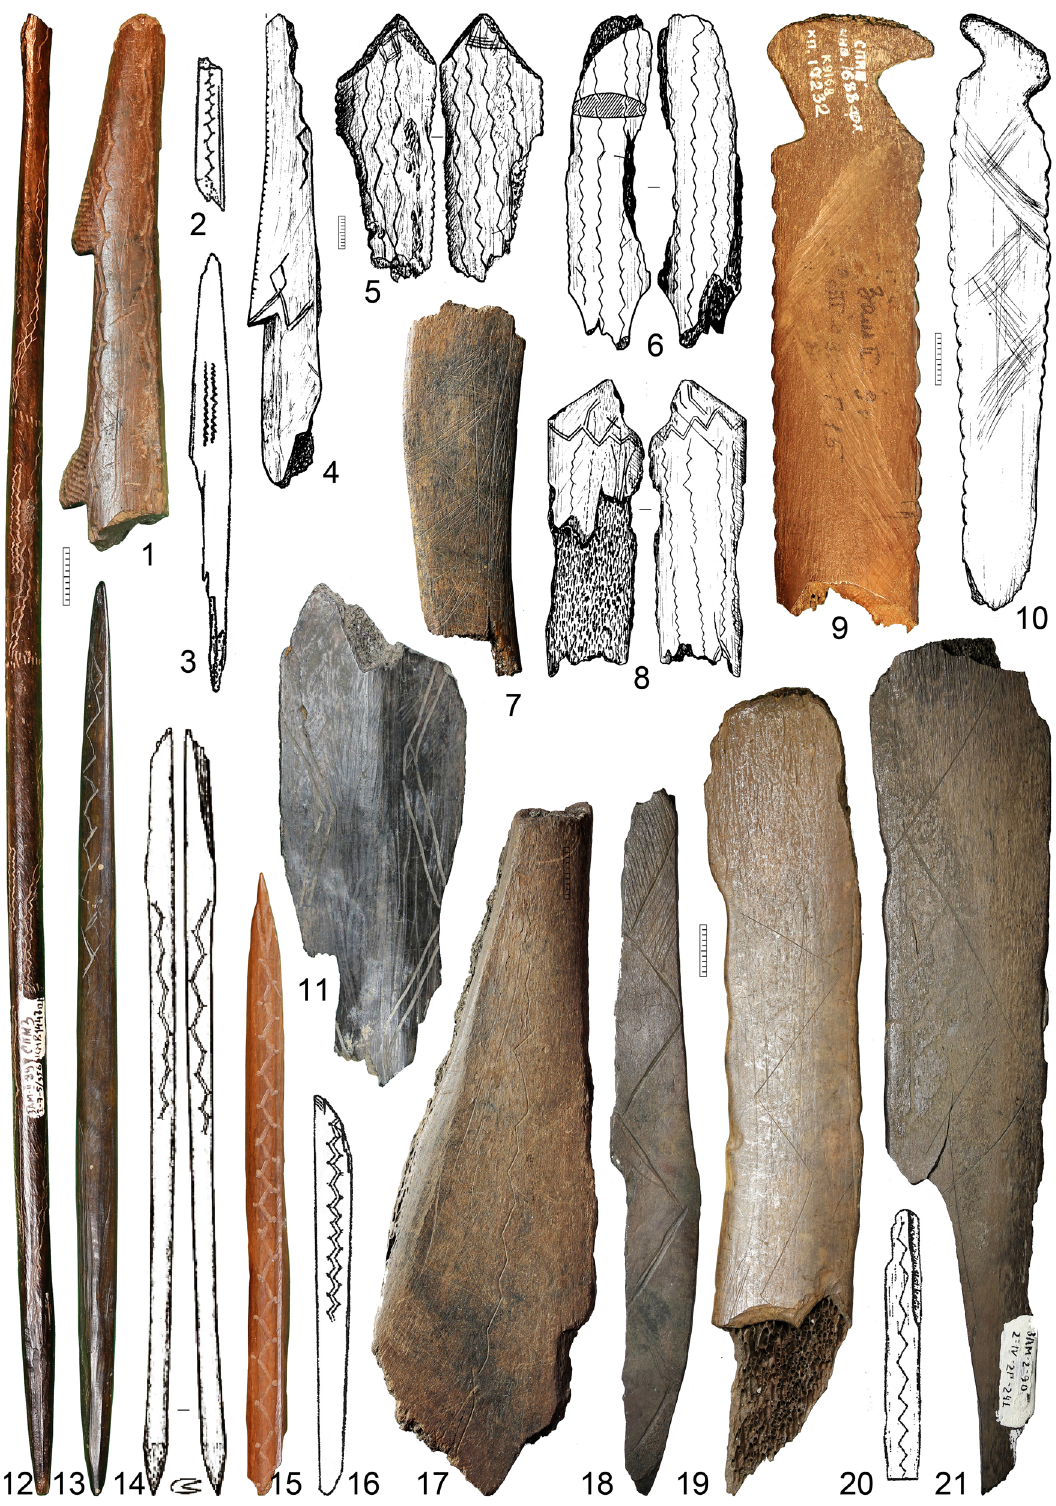
Figure 5: Zamostje 2 ( 1, 4 – 13, 15, 17 – 19, 21 ) , Kamen Dyrovaty ( 2 – 3, 16, 21 ) , Shigir Peat - bog ( 14 ) . ( 1 and 4 ) spearheads; ( 2 – 3, 12 – 16 and 20 ) arrowheads; ( 5 – 10, 19, 21 ) elk rib knives; ( 11 and 17 ) scapula knives. Mesolithic ( 2 – 5, 8 – 16, 18 – 20 ) Early Neolithic ( 1, 7, 17, 21 ) unde fi ned ( 6 ) . Figures 4 – 6, 8, 10 by V. Lozovski. ( 2 – 3, 16, 21 after Serikov, 2001, Figures 42: 10; 49: 7; 51: 6, 9; Savchenko, 2020, Figure 6: 28 )